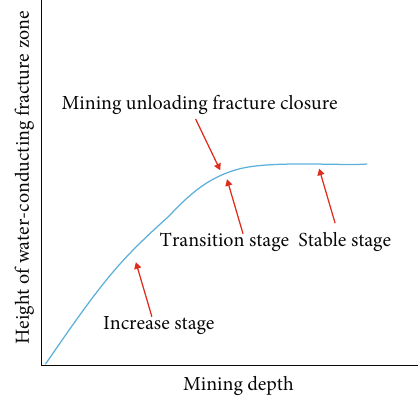
Mining Figure 3: Dynamic evolution stage of the height of the water- conducting fracture zone with mining